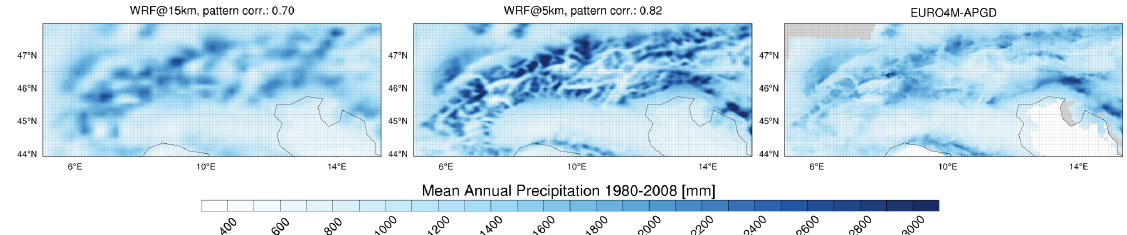
Mean annual precipitation for the WRF reanalysis simulation 1980–2008 (left: D2, ∆ x/ ∆ y = 15 km, center: D3, ∆ x/ ∆ y = 5 km) and the respective EURO4M-APGD observation data (right) for RG2. The spatial pattern correlation between the two model resolutions and observed values is expressed as the centered Pearson product-moment coefficient of linear correlation (0.70 for WRF in the 15 km domain D2, and 0.82 in the 5 km domain